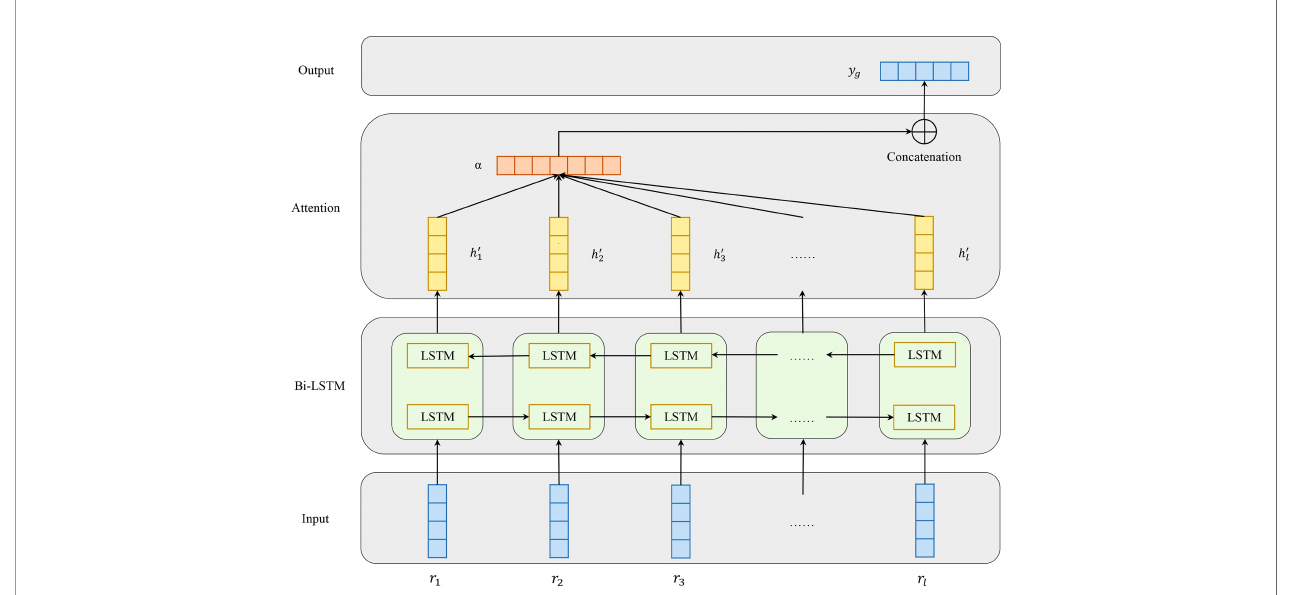
FIGURE 3 | Modelarchitectureofattention-basedbidirectionallong short-term memorynetworkswhichconsists offourparts: input,Bi-LSTM